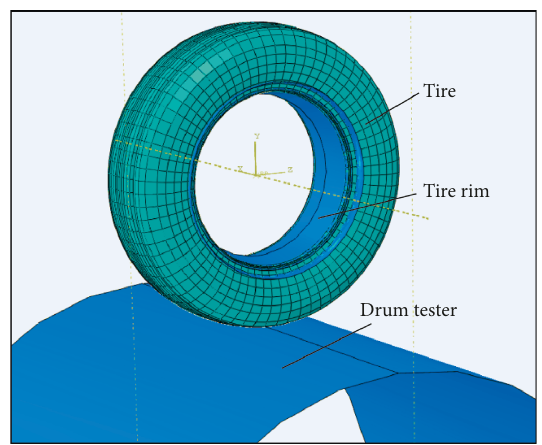
Figure 5: FEA modeling for the tire and the test